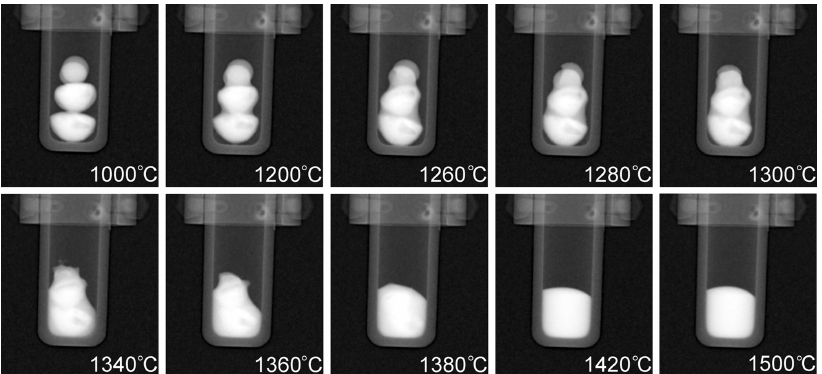
Figure 7. Radiographs taken at increasing temperatures of the CoCrCu + Ni buttons inside the alumina crucible in the HOT-A vacuum furnace. A full movie-like sequence of radiographs can be found in the Supplementary Materials.